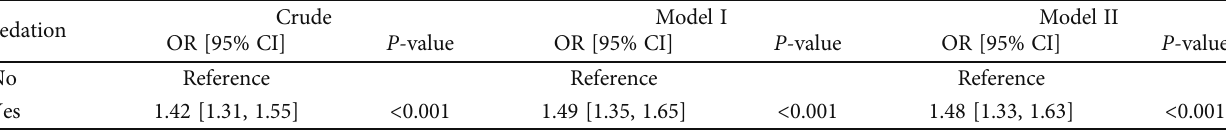
Table 4: Multivariate logistic regression analysis models evaluating the association between sedation and adenoma detection